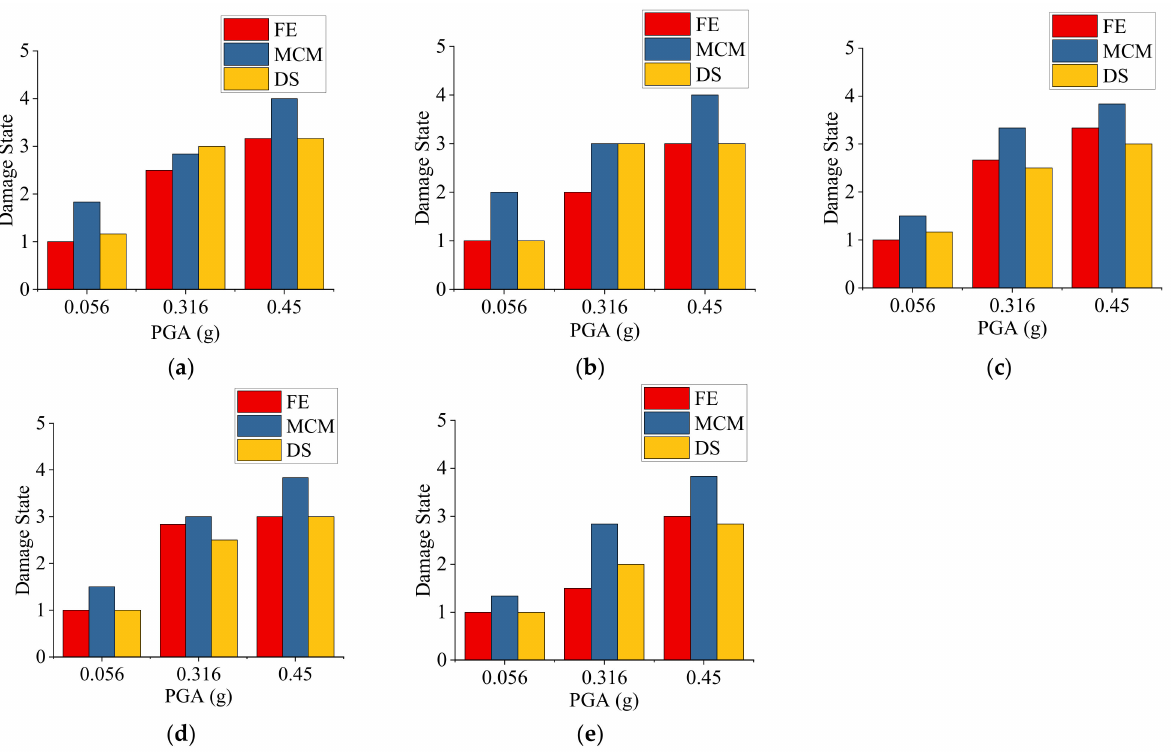
Figure 7. Seismic damage state prediction results using the refined FE model with THA, the MCS model with THA, and the design-strength-based method: ( a ) 3-story structure; ( b ) 5-story structure;